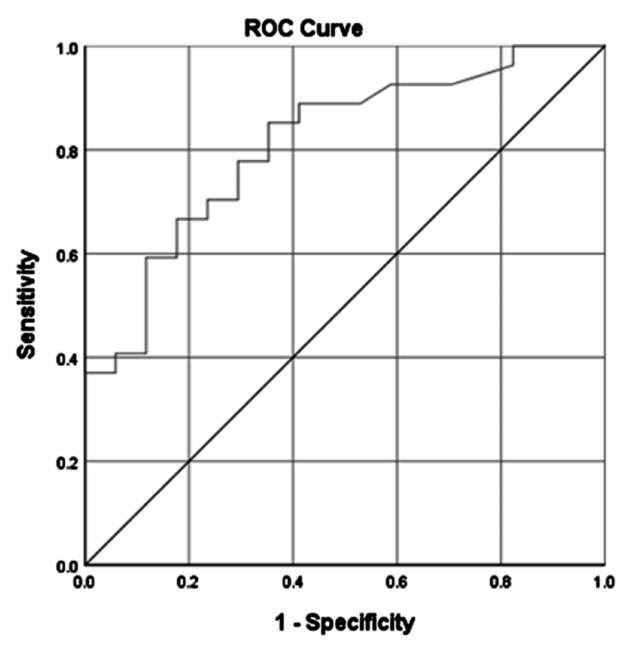
Figure 2. Receiver operating characteristic curve (ROC) analysis for the occurrence of death in relation to the lactate concentration at time point T4. AUROC (area under the receiver operating characteristic curve)—0.812. Standard error—0.065. p < 0.001. 95% CI—0.684–0.939. Cut-off point (95% CI) > 12.55. Sensitivity (%) of cut-off value—85. Specificity (%) of cut-off